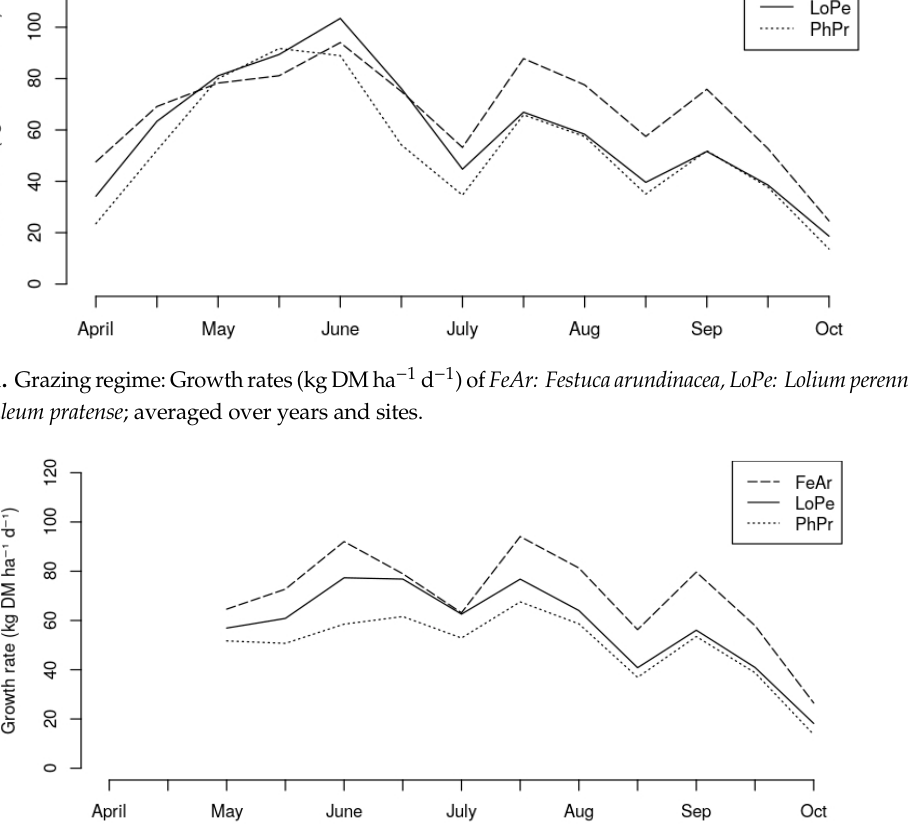
Figure 2. Combined regime: Growth rates (kg DM ha − 1 d − 1 ) of FeAr: Festuca arundinacea, LoPe: